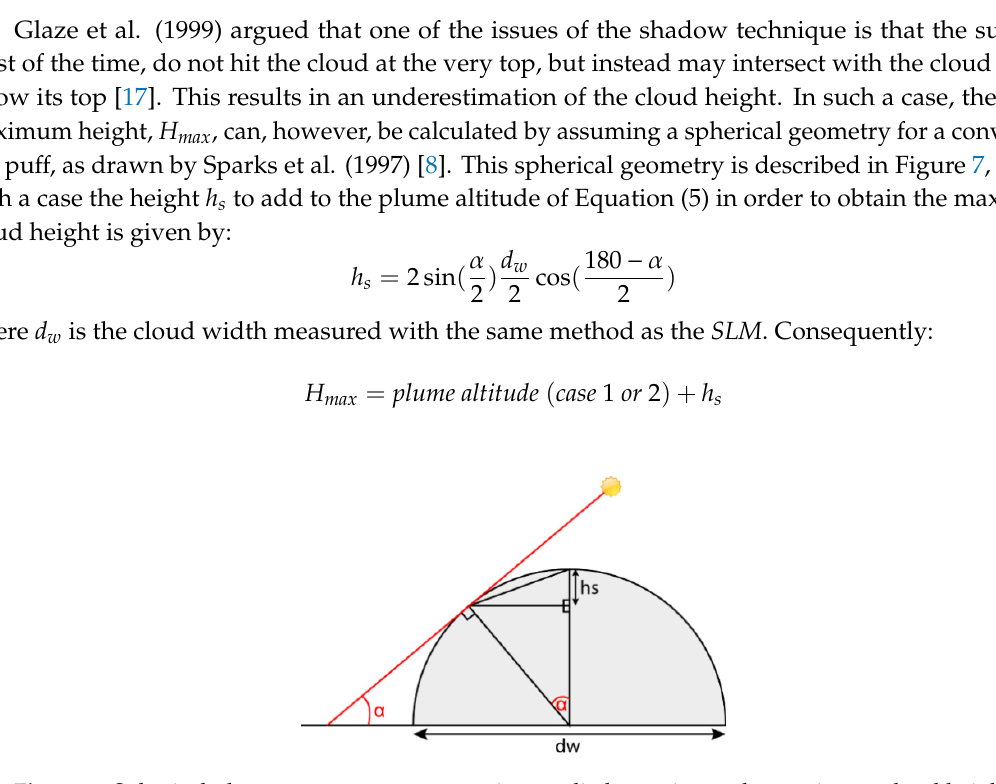
Figure 7. Spherical plume top geometry correction applied to estimate the maximum cloud height; a case to be used when sunrays intersect with the plume not at the very top of the plume, but a little below.